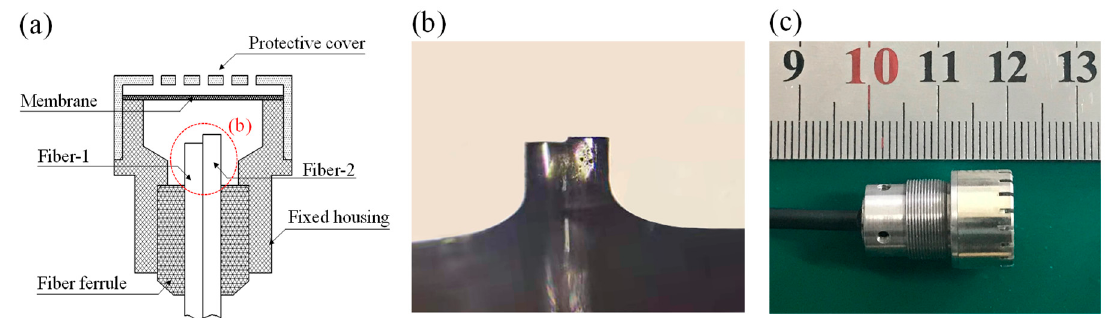
Figure 9. Schematic diagram of Q–FFPM probes ( a ). Microscopic photo of a short step fiber pair ( b ). The diameter of the fiber shown in Figure 9b is 125 µ m. Digital photo of a Q–FFPM probe sample ( c ).